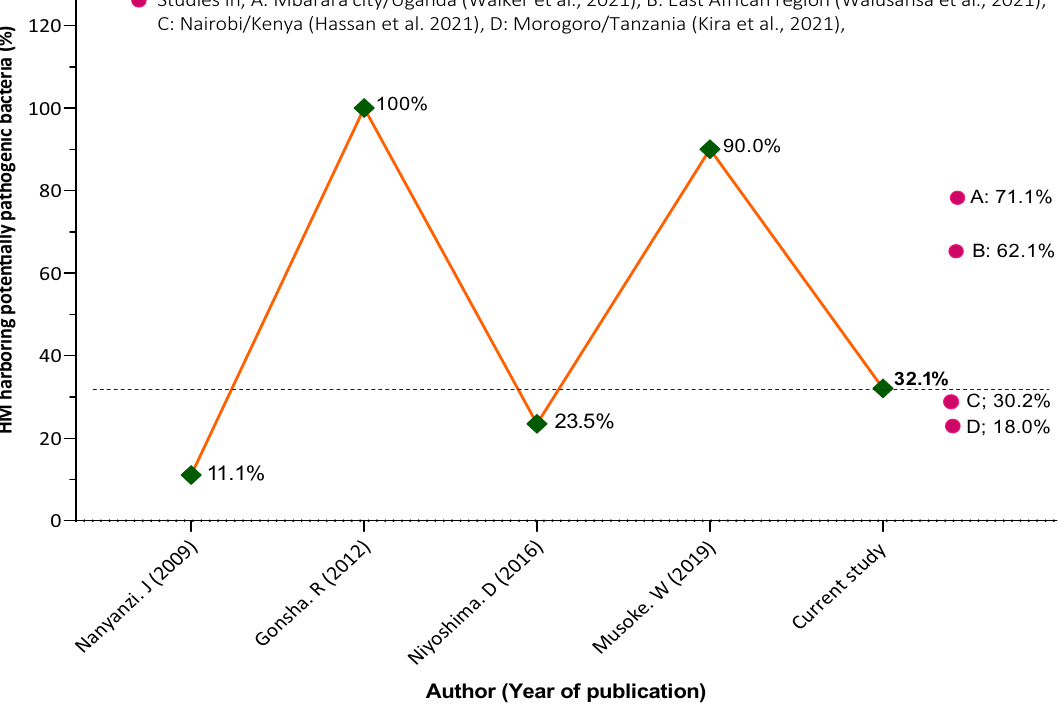
Figure 6. % of herbal medicines (HM) reported to be contaminated with potentially pathogenic bacteria in Kampala and its neighborhoods 1,5,6,14,17,44,45,51